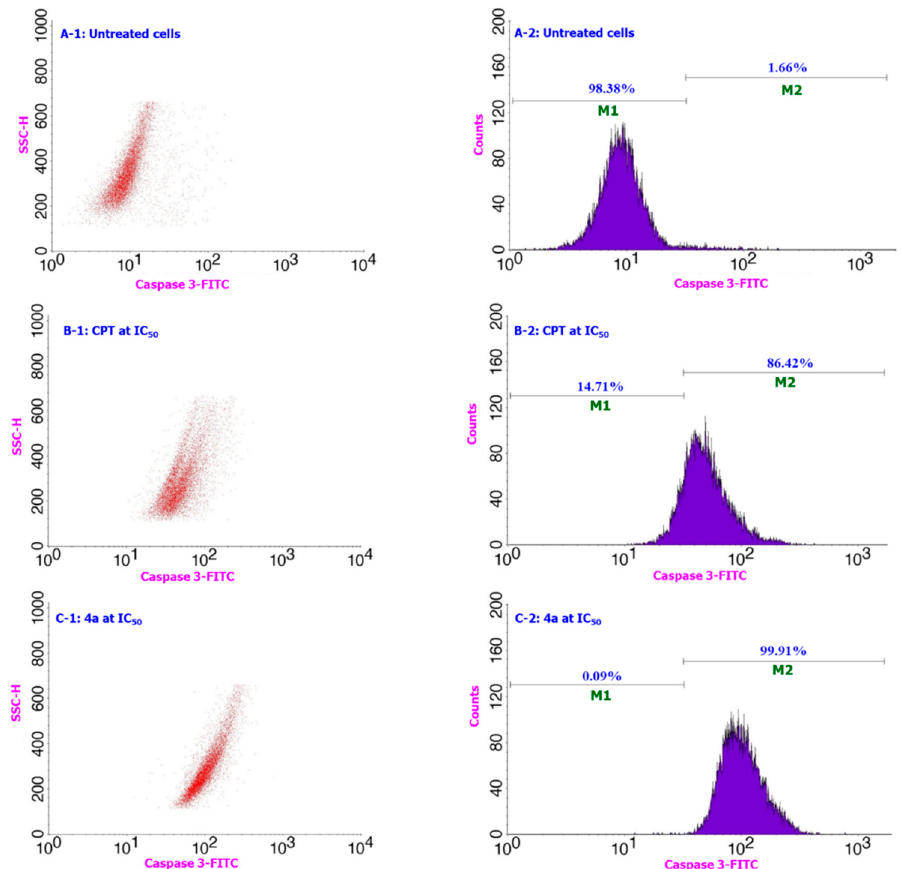
Figure 8. Comparison of compound 4a (C-1 and C-2) induced caspase-3 activity for the A549 cells with that of positive (B-1 and B-2) and negative (A-1 and A-2) controls over a 48 h incubation period.